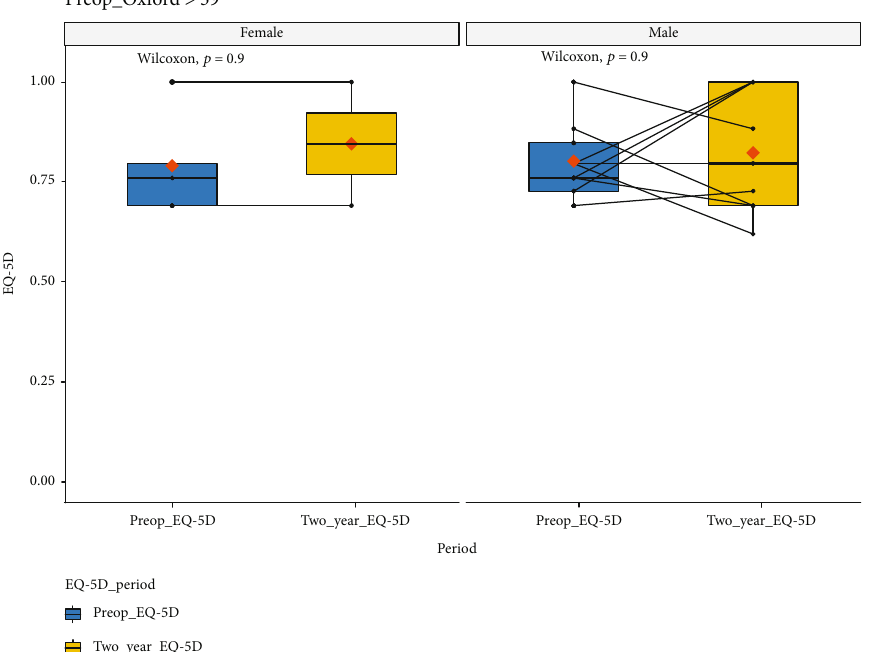
Figure 2: EQ-5D scores at baseline and 2-year follow-up for all those with OKS > 39 . Male and female data have been plotted separately. x -axis: EQ-5D for the quality-of-life score at preoperative baseline and at two-year follow-up. y -axis: EQ-5D for the quality- of-life score value; boxplot showing L -estimators: outliers plotted as individual points at 2-year follow-up. Full data tabulated in Table 1. Connecting lines: heuristic visualization of single-patient trajectories of variation of EQ-5D for the quality-of-life score value for function between preoperative baseline and two-year follow-up; plotted with R (version 4.0.0 or higher; libraries ggpubr and PairedData). Source: authors ’ data and reproducible statistical analysis with open access statistical software R (version 4.0.0 or higher). Table 2: EQ-5D score at preoperative baseline and at two-year follow-up for all patients with OKS > 39 at baseline. Female Male OKS >